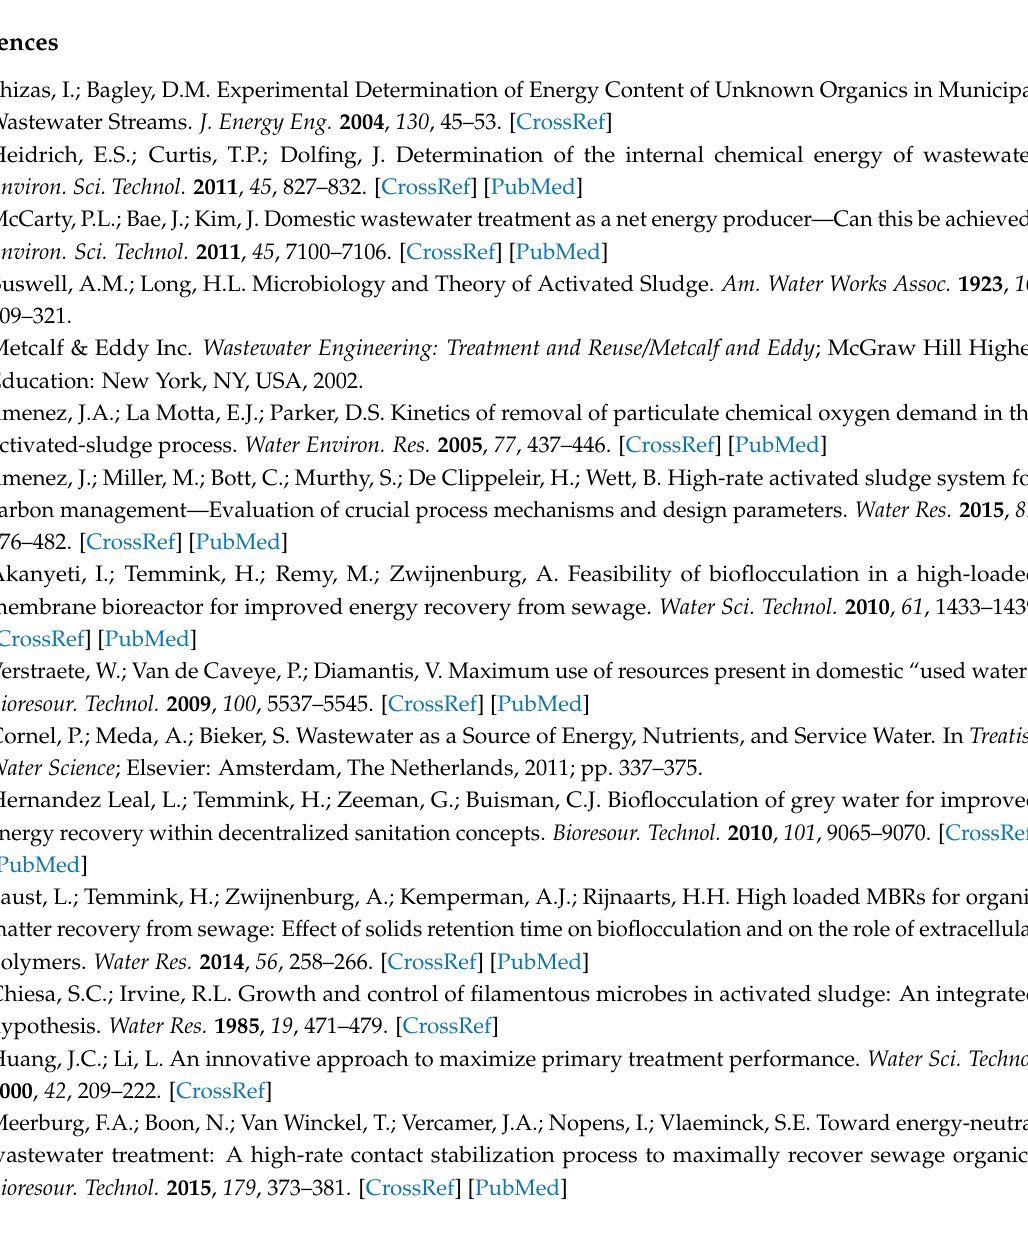
Figure S1: Impacts of proteins increase in LB-EPS and TB-EPS fraction of two MBRs (A, C for HL-MBR; B, D for HRCS-MBR) on changes of COD fractions (%) at different SRTs. Table S1: NH4 + -N and TP concentrations of concentrates in both MBRs at different SRTs; Table S2: COD concentrations of concentrates in both MBRs at different